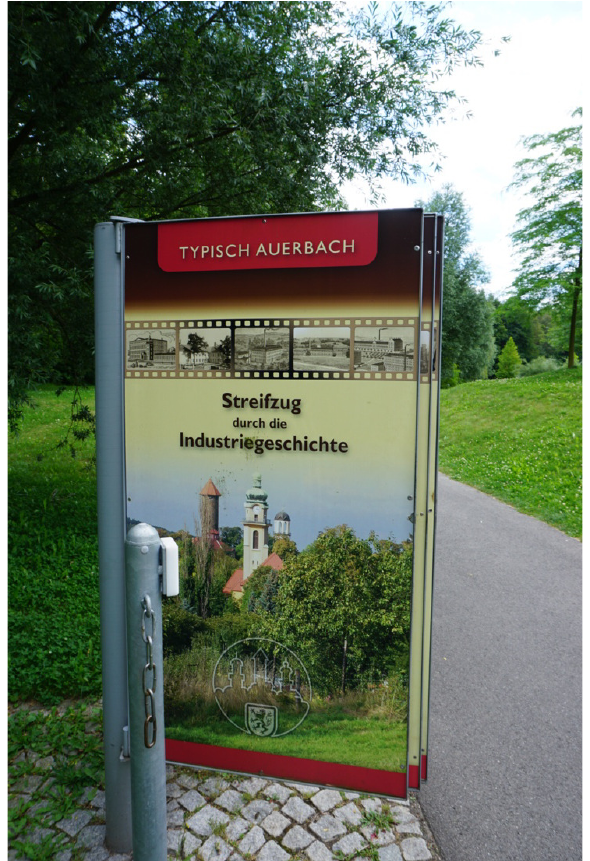
Figure 3. Numerous memorial plates along the region indicate the general importance of the industrial past for the people, like here in Auerbach, Saxony, titled “Expedition Through the Industrial Past”